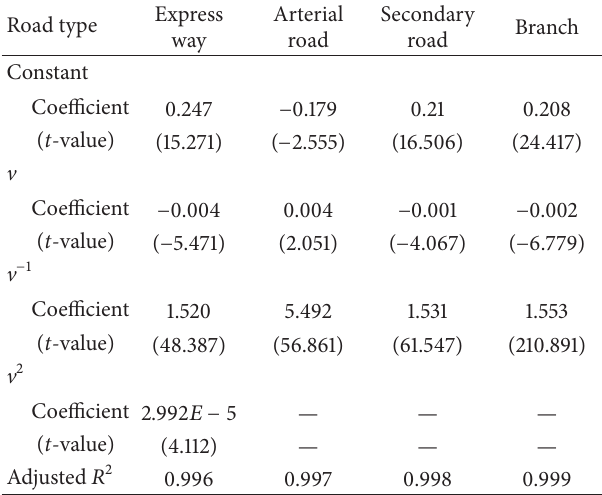
Table 2: Results of parameters calibration for energy consumption factor models.